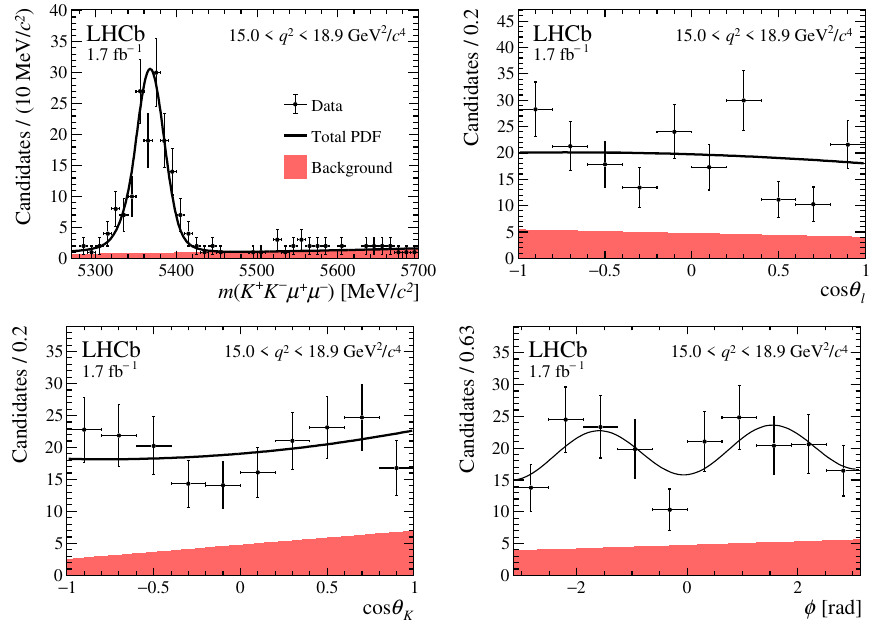
Figure 31 . Mass and angular distributions of B 0 15 . 0 < q 2 < 18 . 9 GeV 2 /c 4 for data taken in 2016. The data are overlaid with the projections of the fitted